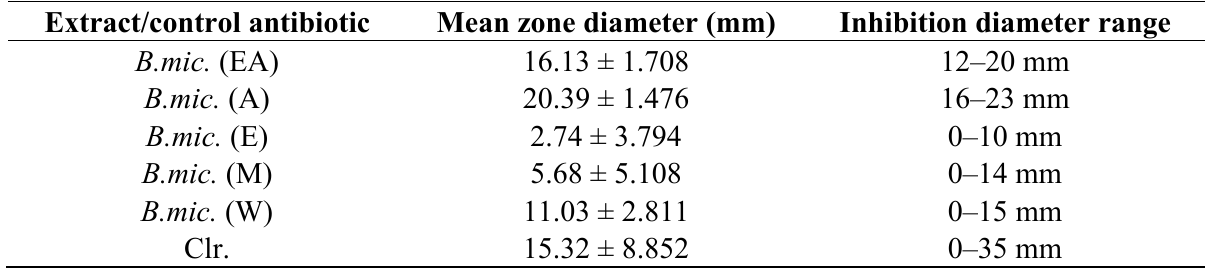
Table 2. Mean zones and inhibition diameter range of the crude extract and